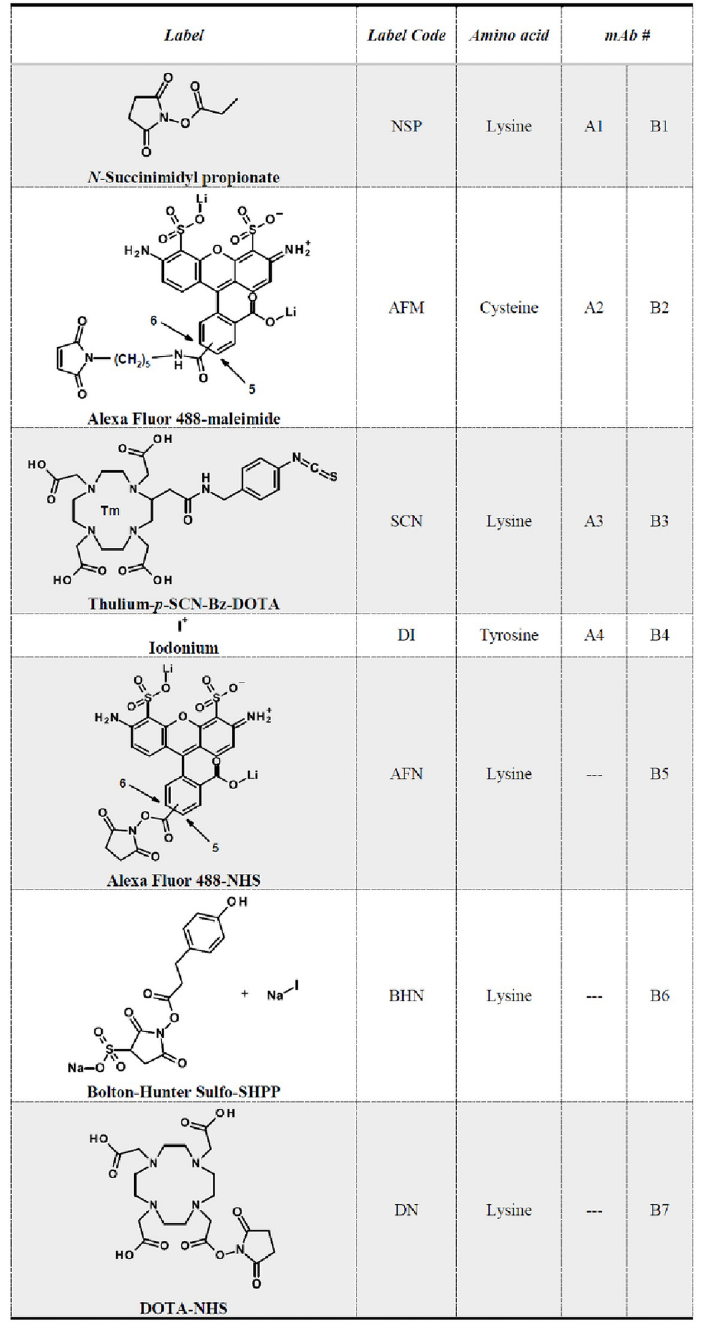
Fig 2. Labels used in this study. Chemical structures of labels used in this study. Label Code describes the abbreviations of each label mentioned in this study. Column “Amino acid” shows the corresponding amino acid involved in the labelling process. Alphanumeric links to the modified mAbs are given in the two right-hand columns: mAbA1-4: wildtype mAb; mAbB1-7: research concept mAb.